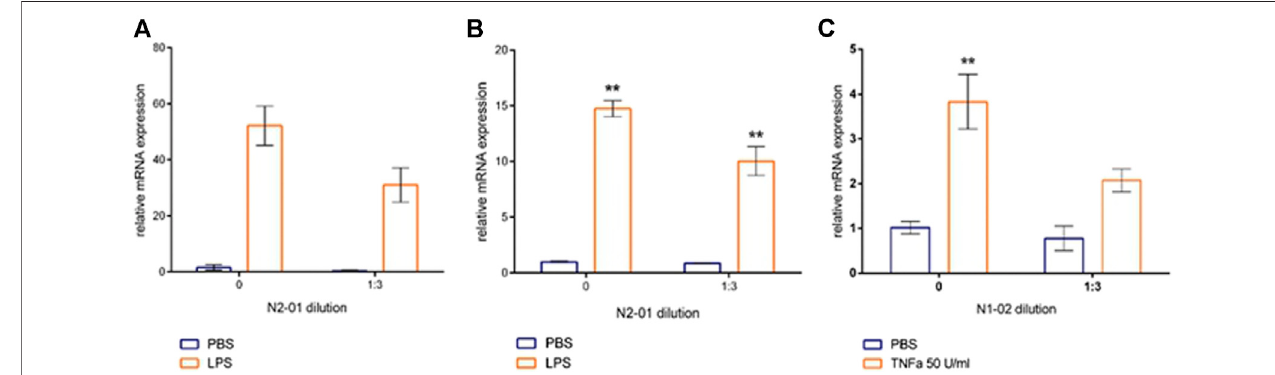
FIGURE 8 | The effect of N2-01 on the VCAM-1 (A) , ICAM-1 (B) adhesion molecules and IL-6 transcripts in human umbilical endothelial cells (C). Statistical assessment of differences was performed using ANOVA ( p < 0.001), and pairwise comparison of the mean values was performed using the Tukey HSD test. Data are expressed as mean ± SEM of three individual experiments ( n (cid:2) 3). The differences are signi fi cant: ** - p < 0.01 vs control.